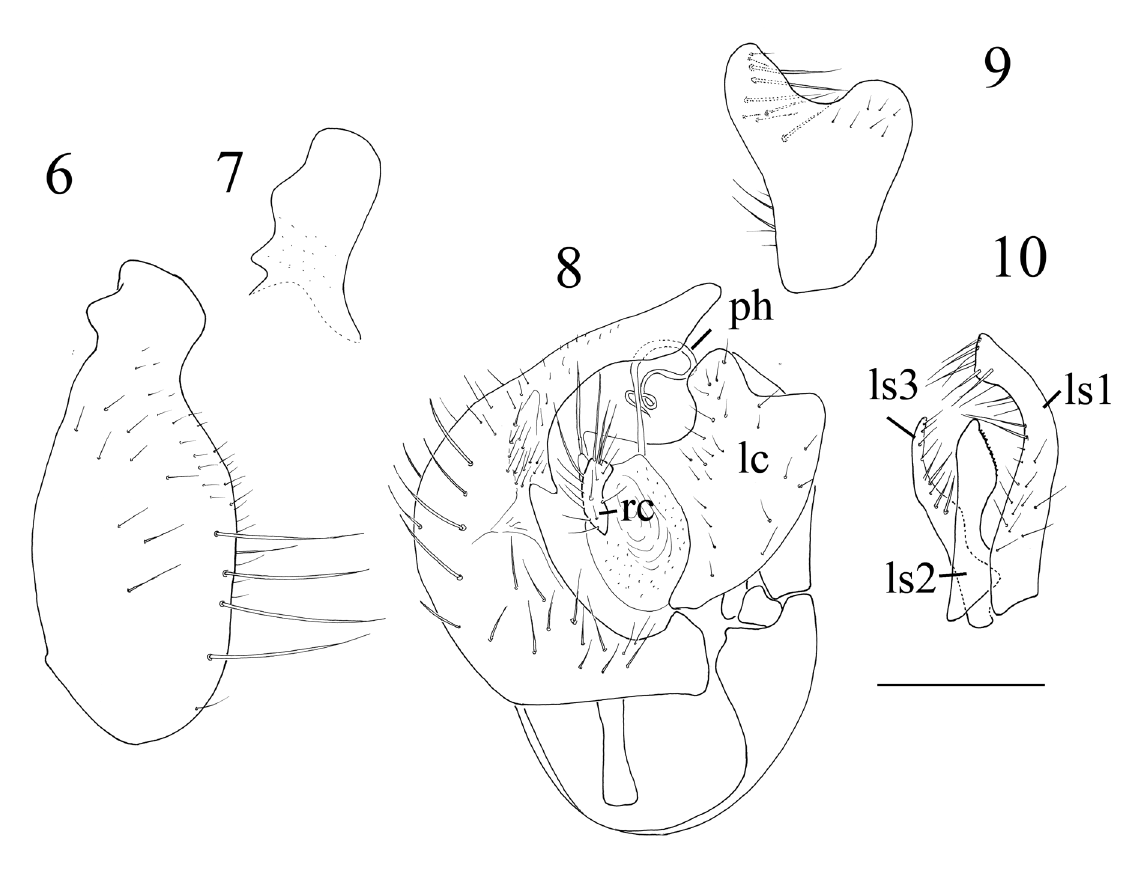
Figs 6–10. Elaphropeza balinensis sp. nov. Male terminalia. 6 . Right epandrial lamella. 7 . Detail of right surstylus. 8 . Epandrium with cerci. 9 . Left surstylus, ls1. 10 . Left surstylus. lc = left cercus; ls1, ls2, ls3 = 3 sclerites of the left surstylus; ph = phallus; rc = right cercus. Scale bar = 0.1